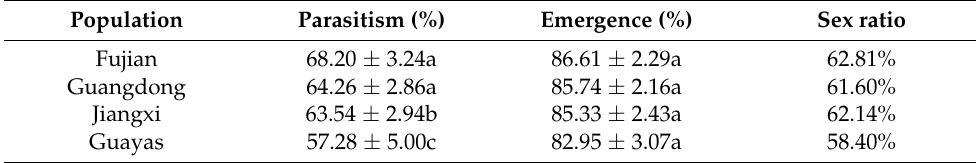
Table 2. Means and SE of the parasitism, emergence, and sex ratio of different populations of Tamarixia radiata in third–fifth instar nymphs of Diaphorina citri